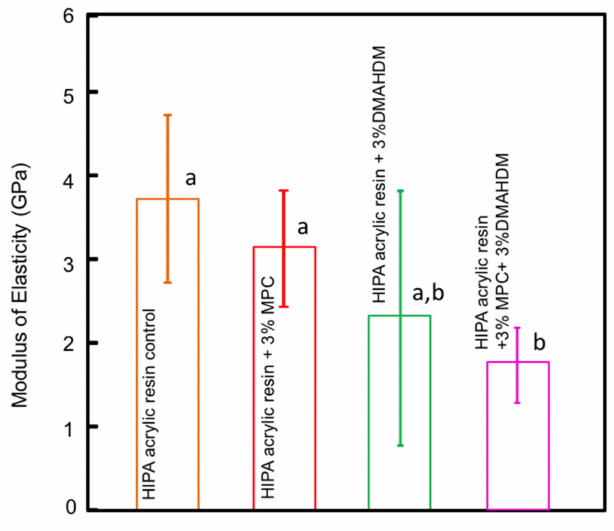
Figure 3. Acrylic resin modulus of elasticity; similar letters indicate statistical similarity (Tukey’s test, p <